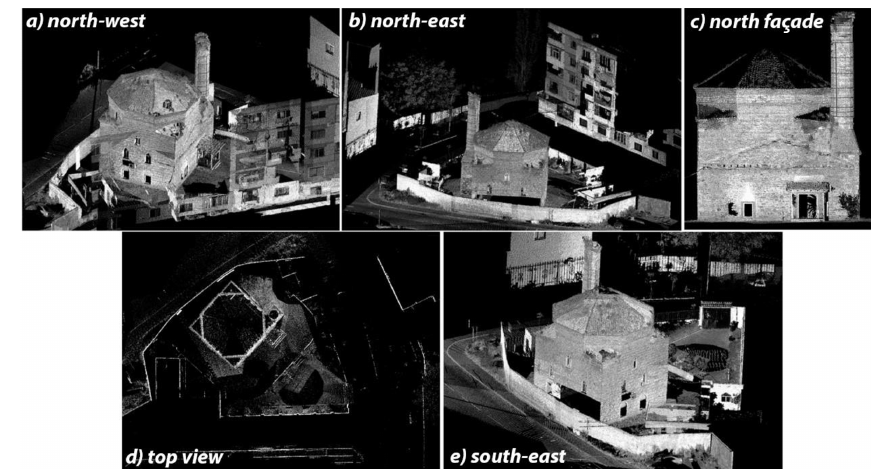
Figure 4. Laser scanner view of the structure from different scan stations (May 2012): (a) northwest, (b) northeast, (c) north façade, (d) top view, (e) southeast corner.